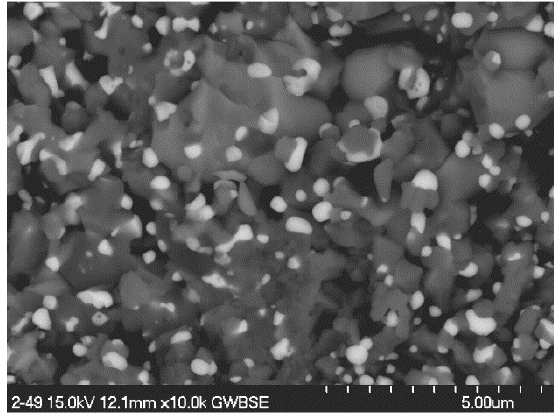
Figure 10. Small NiTa 2 O 6 spheroids atop NiAl 2 O 4 fine grains on 2-49 alloy (1011). 200 h cyclic oxidation at 1100 °C.